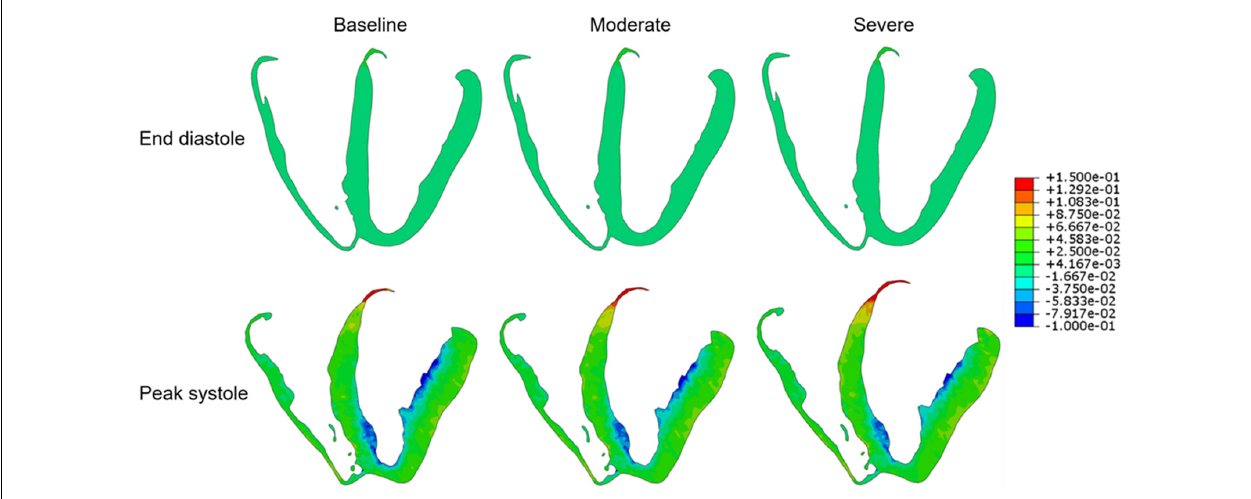
FIGURE 2 | Long-axis cross-sectional views of the left ventricle demonstrating myofiber stress at end diastole (upper row) and peak systole (lower row) for each of the three simulation conditions: baseline, moderate aortic stenosis, and severe aortic stenosis.